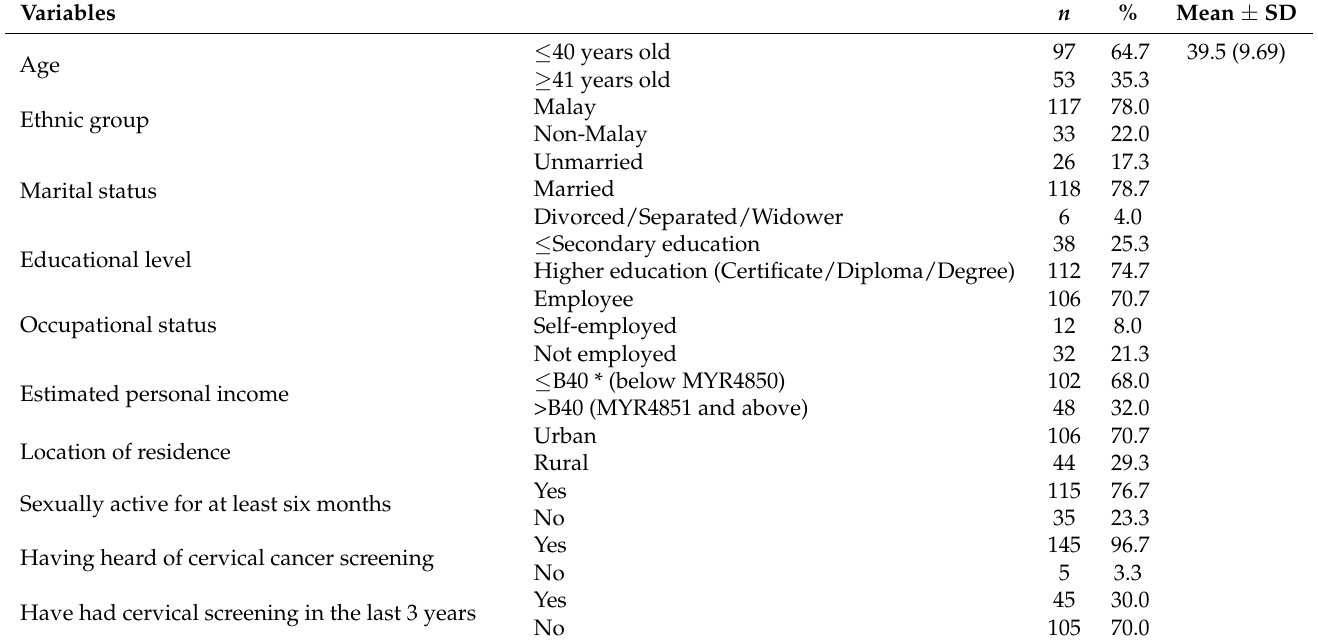
Table 2. The demographic profile of women for reliability testing.